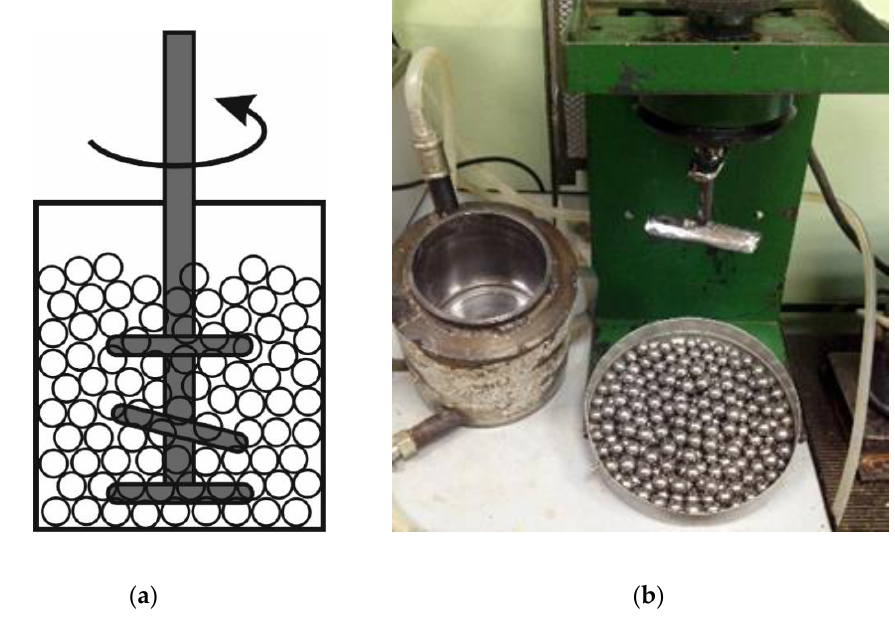
Figure 2. Schematic showing the principle of action ( a ) and a real-world example of an attritor designed at the Institute of Solid State Chemistry and Mechanochemistry, SB RAS ( b ).